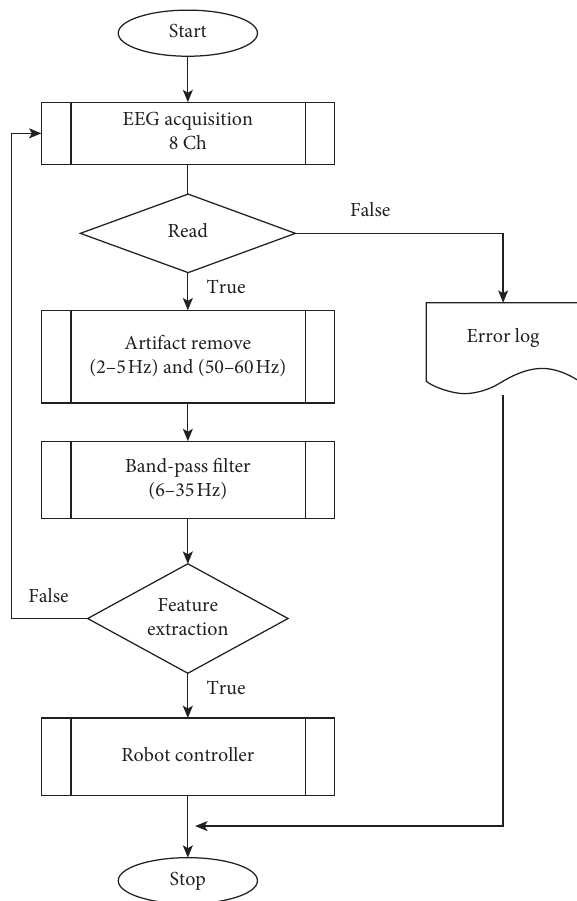
Figure 5: Program flowchart of the proposed